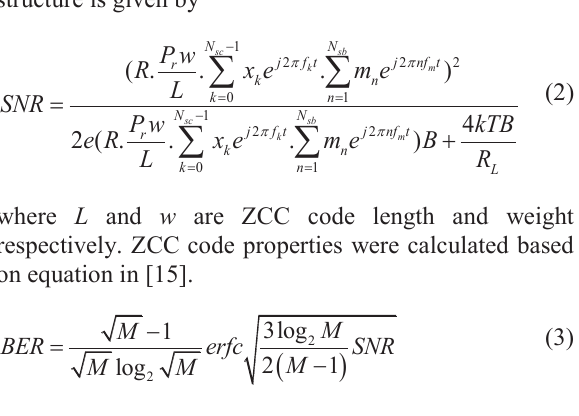
Fig. 1 Multiband catenated OFDM